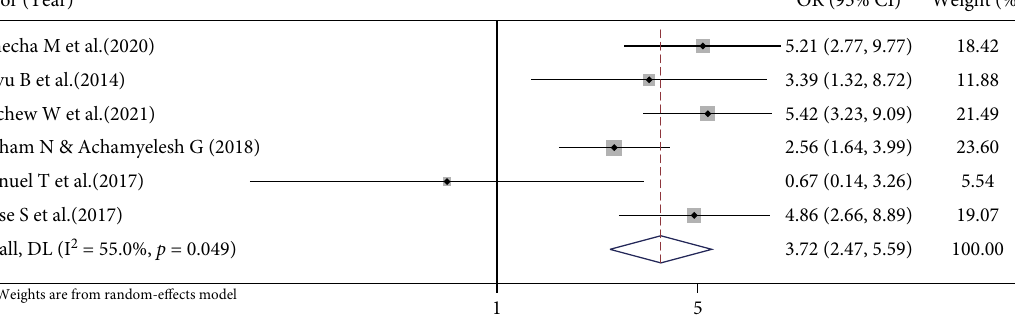
Figure 8: Forest plot for the e ff ect of not being satis fi ed with service on Implanon discontinuation, a systematic review and meta-analysis, Ethiopia,